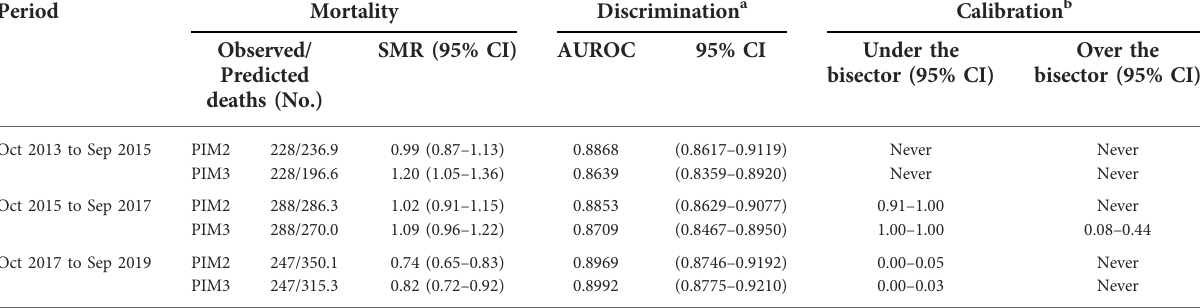
PIM, pediatric index of mortality; SMR, standardized mortality rate; CI, con fi dence interval; AUROC, area under the receiver operating characteristic curve. a AUROCs were signi fi cantly different by DeLong method in period 1 ( Z =3.1146, P =0.0018, 95% CI AUC difference [0.0085;0.0373]) and in period 2 ( Z =2.4686,